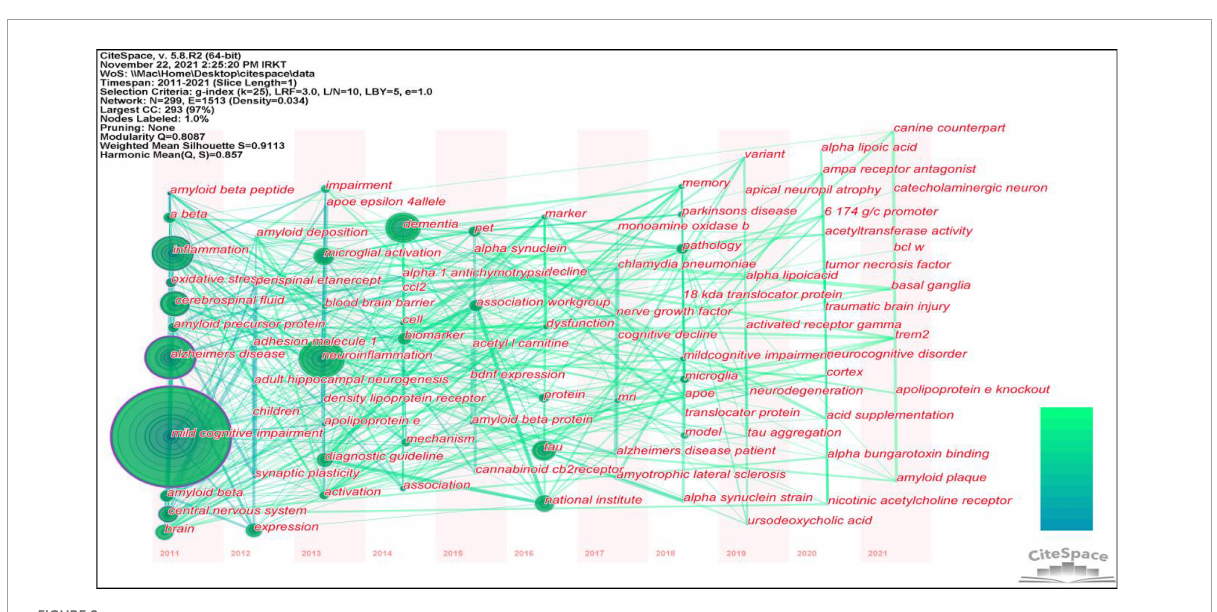
FIGURE8 The co-citation network visualizations map of keywords created using VOSviewer. Node size and color represents the number of keywords and cluster.